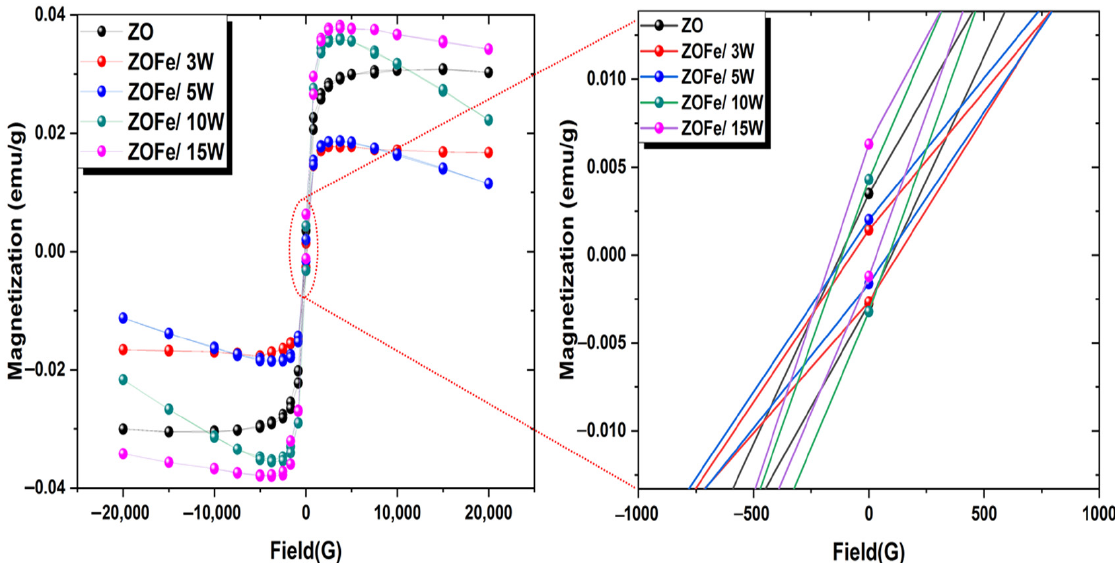
Figure 15. M-H curve showing ferromagnetic loops for the undoped and Fe doped ZO thin films.